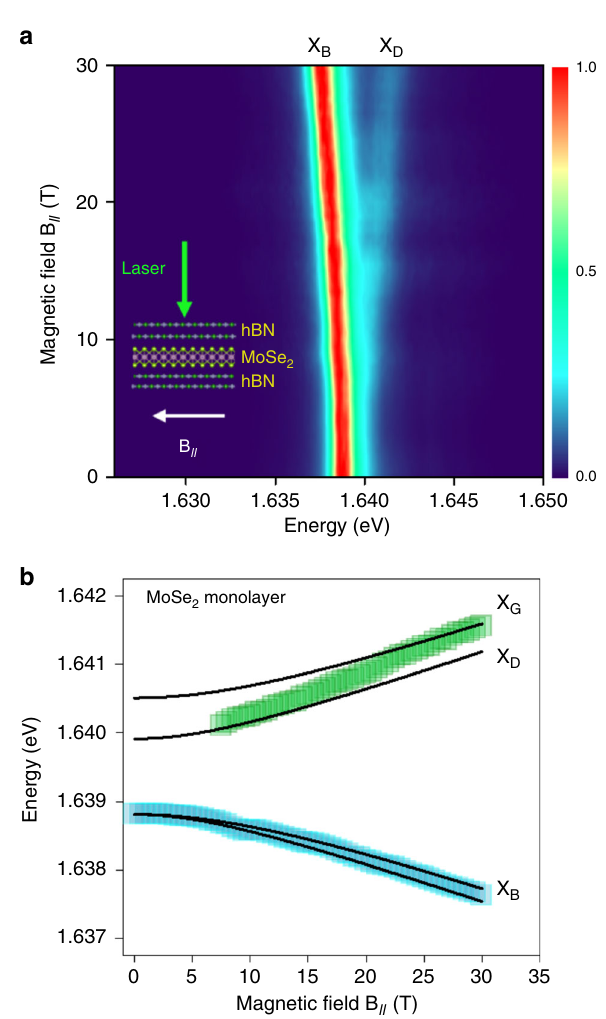
Fig. 2 In-plane magnetic fi eld B // — spin-forbidden dark exciton in MoSe 2 monolayer encapsulated in hBN revealed by photoluminescence. a Color map of the variation of the PL intensity as a function of B // (the PL intensity of the bright exciton has been normalized at each fi eld); b energy of dark and bright excitons as a function of B // . The solid lines correspond to the fi t described in the